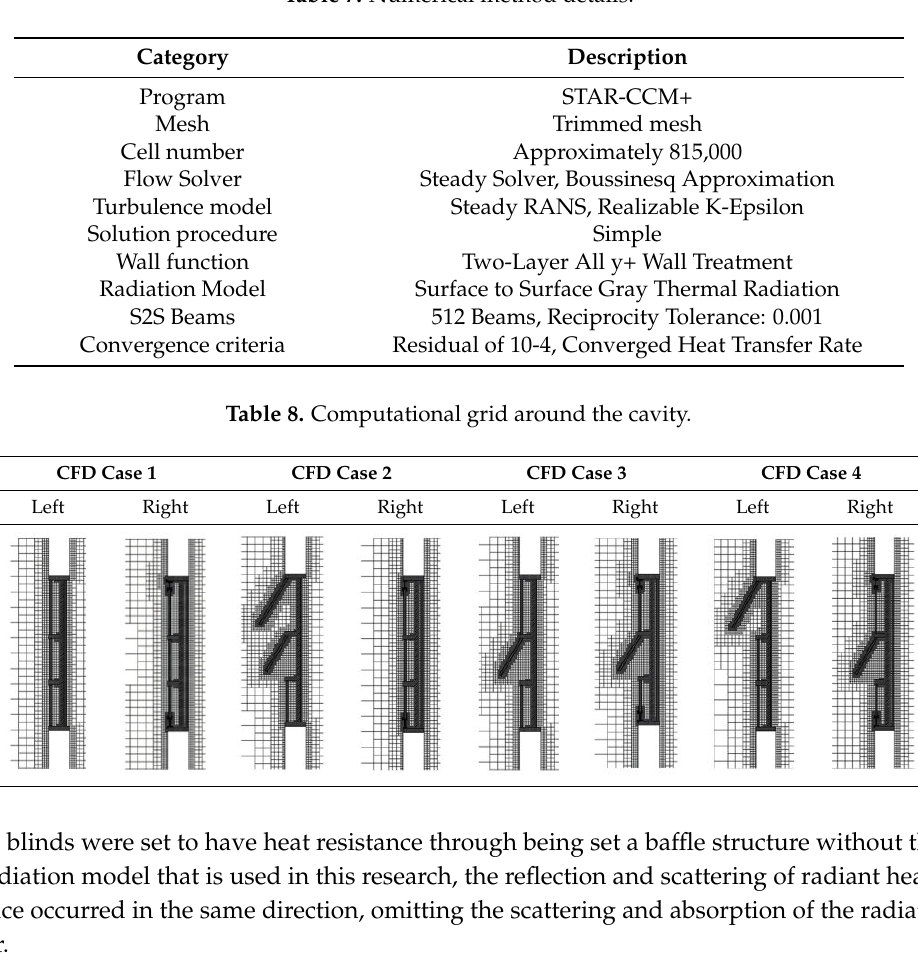
Table 7. Numerical method details.